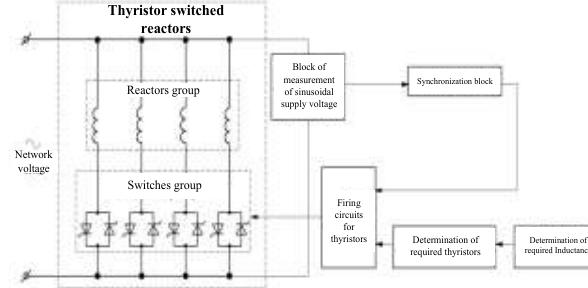
Fig. 6. Block diagram of TSR control system